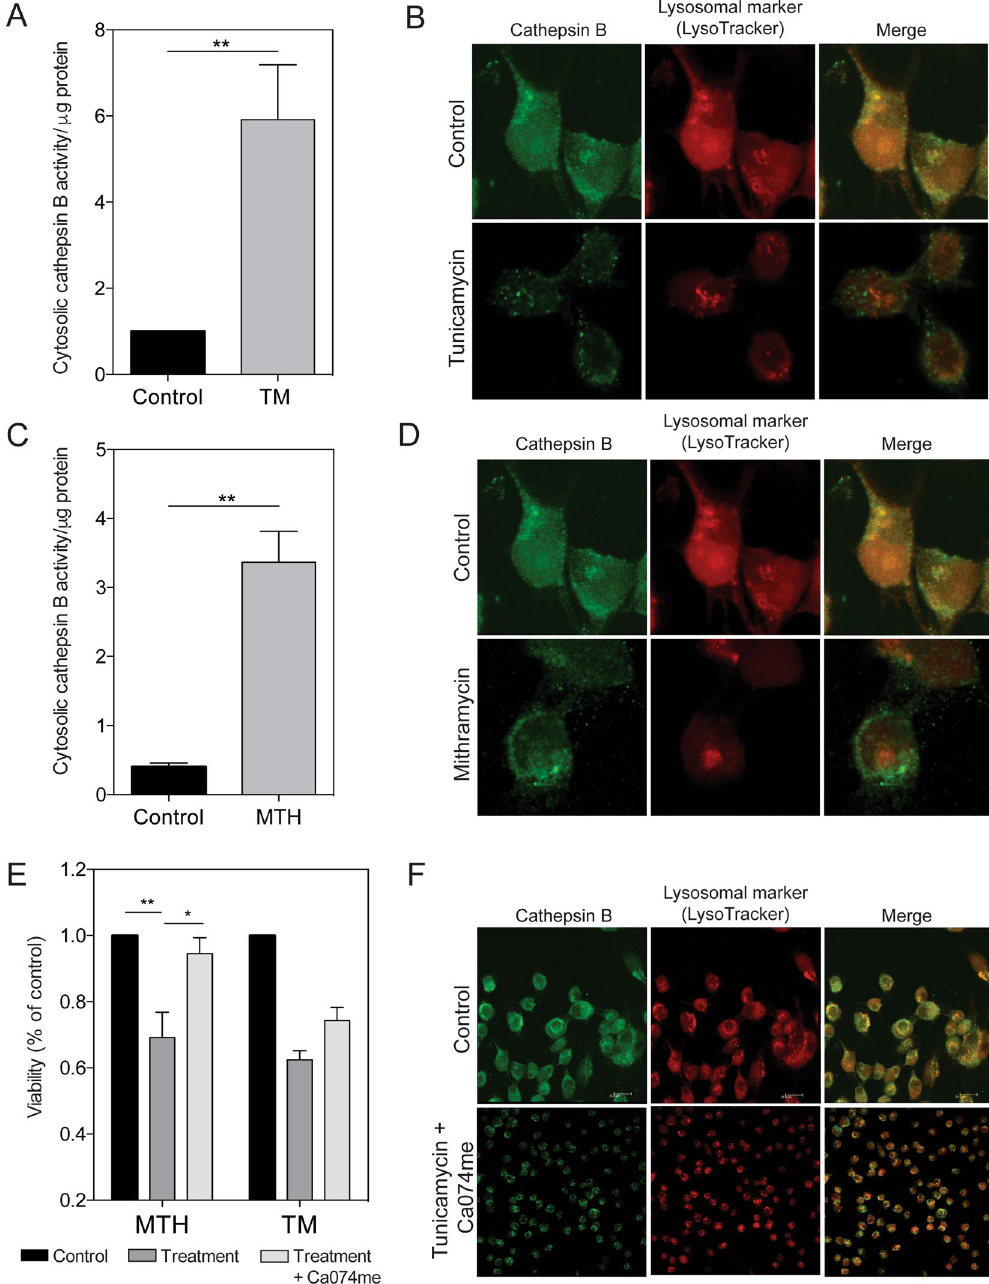
Figure 3. ER stress leads to a disruption in the lysosomal membrane. MIA PaCa-2 cells analyzed for lysosome membrane permeabilization. ( A ) Cells treated with 1 μ M tunicamycin and analyzed for cytosolic cathepsin B activity. ( B ) Cells treated with 1 μ M tunicamycin, and stained with cathepsin B and lysotracker. Images taken at 60x magnification. ( C ) Cells treated with 100 nM mithramycin and analyzed for cytosolic cathepsin B activity. ( D ) Cells treated with 100 nM mithramycin, and stained with cathepsin B and lysotracker. Images taken at 60x magnification. ( E ) Viability determined for cells treated with 100 nM mithramycin or 1 μ M tunicamycin, with and without a cathepsin B inhibitor, Ca074me. ( F ) Cells treated with 1 μ M tunicamycin, with and without Ca074me detected by immunofluorescence. Images taken at 40x and 60x